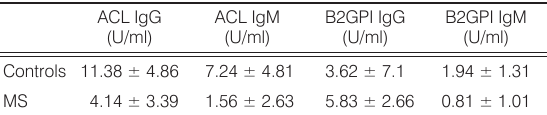
Table 2. Levels of anti-cardiolipin (ACL) and anti-beta-2- glycoprotein I (B2GPI) antibodies in patient with multiple sclerosis (MS) and